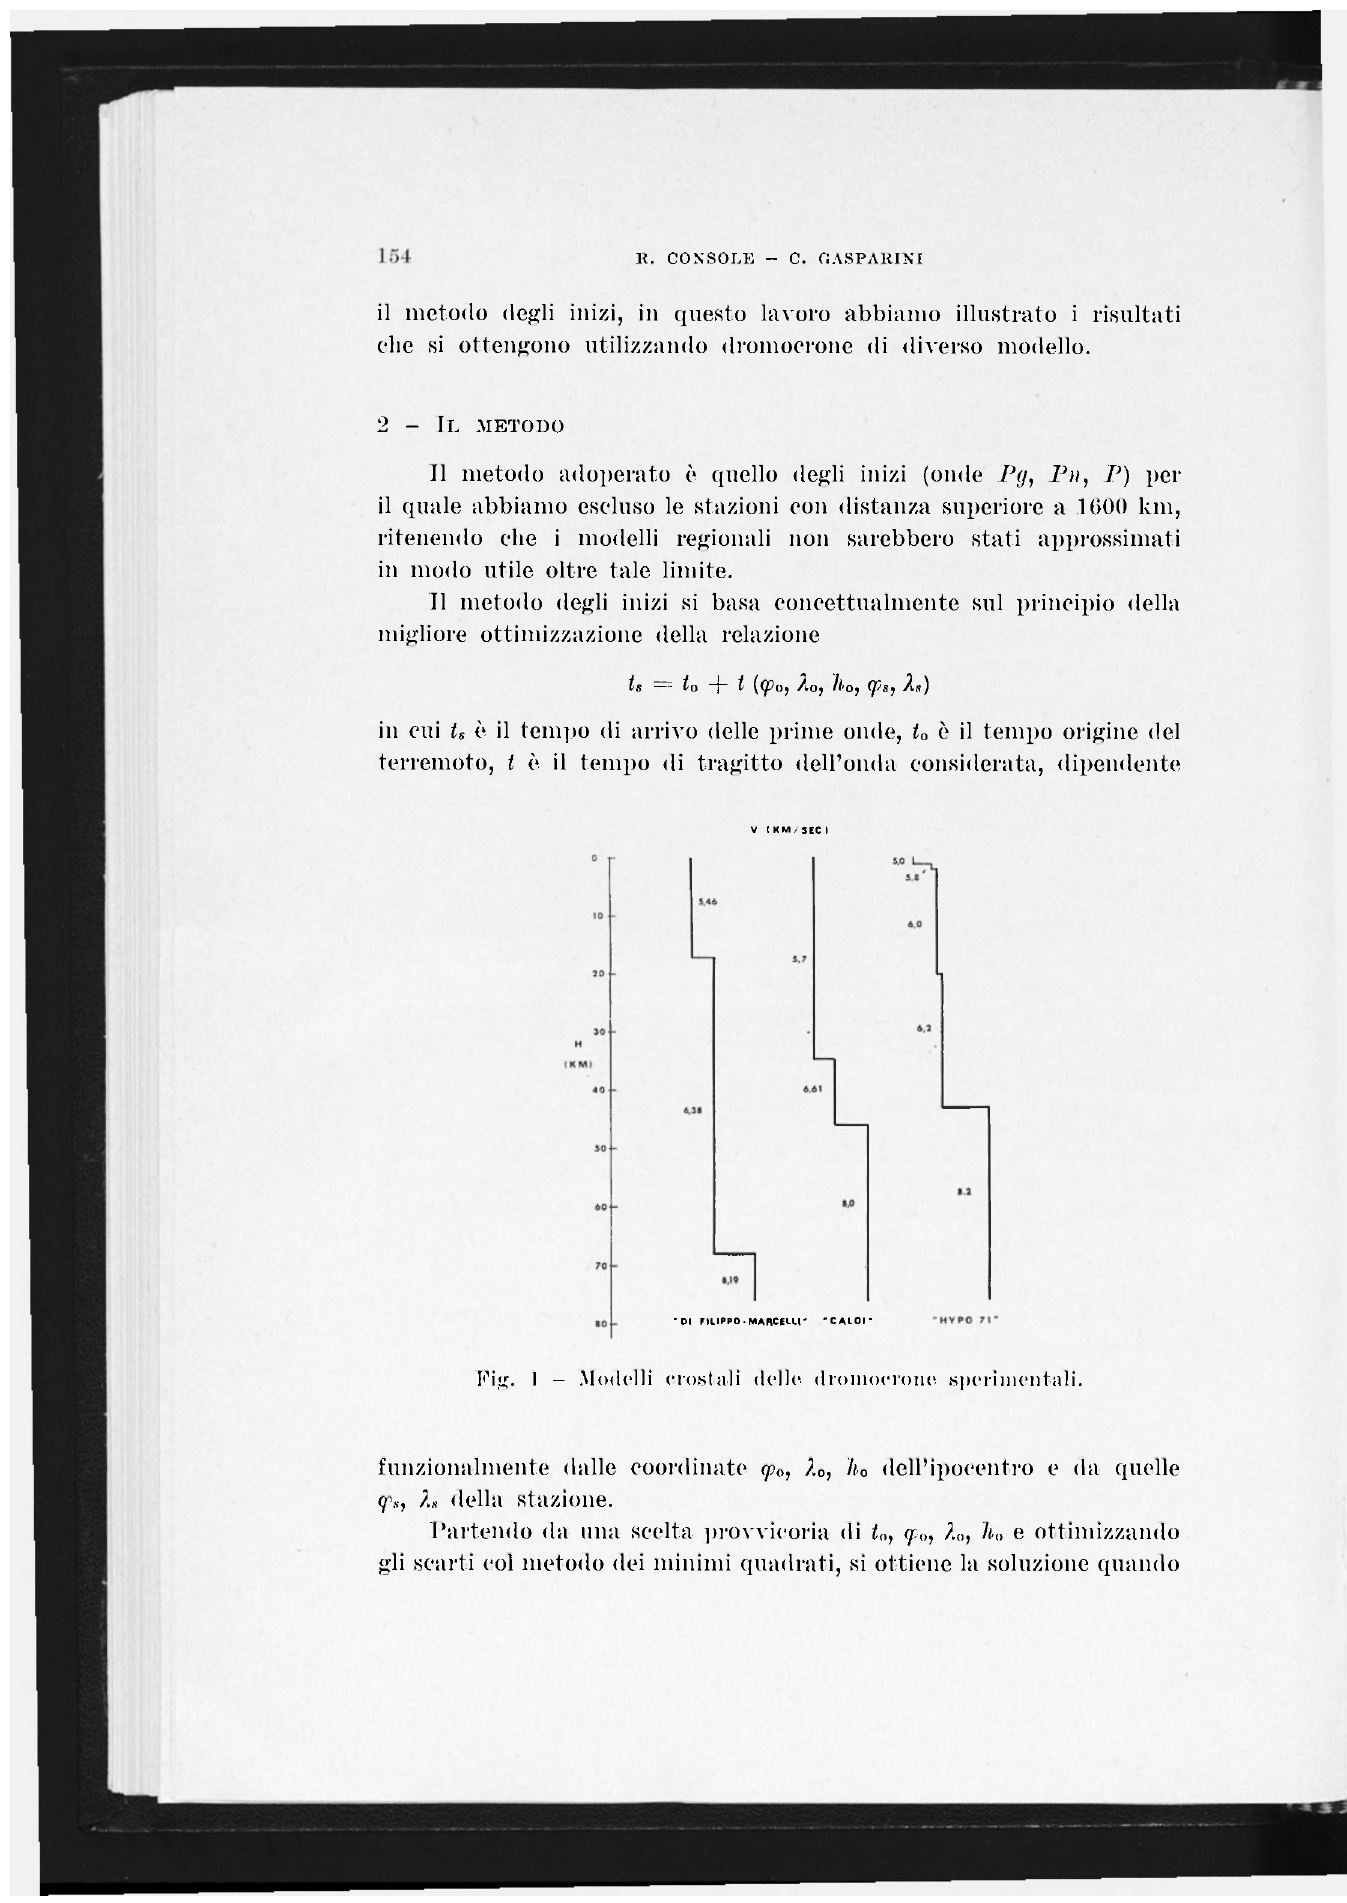
Fig. I Modelli crostali delle dromocrone